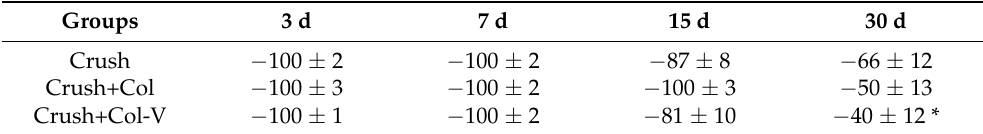
Table 1. Functional deficit of the injured limb relative to the intact limb in % after sciatic nerve